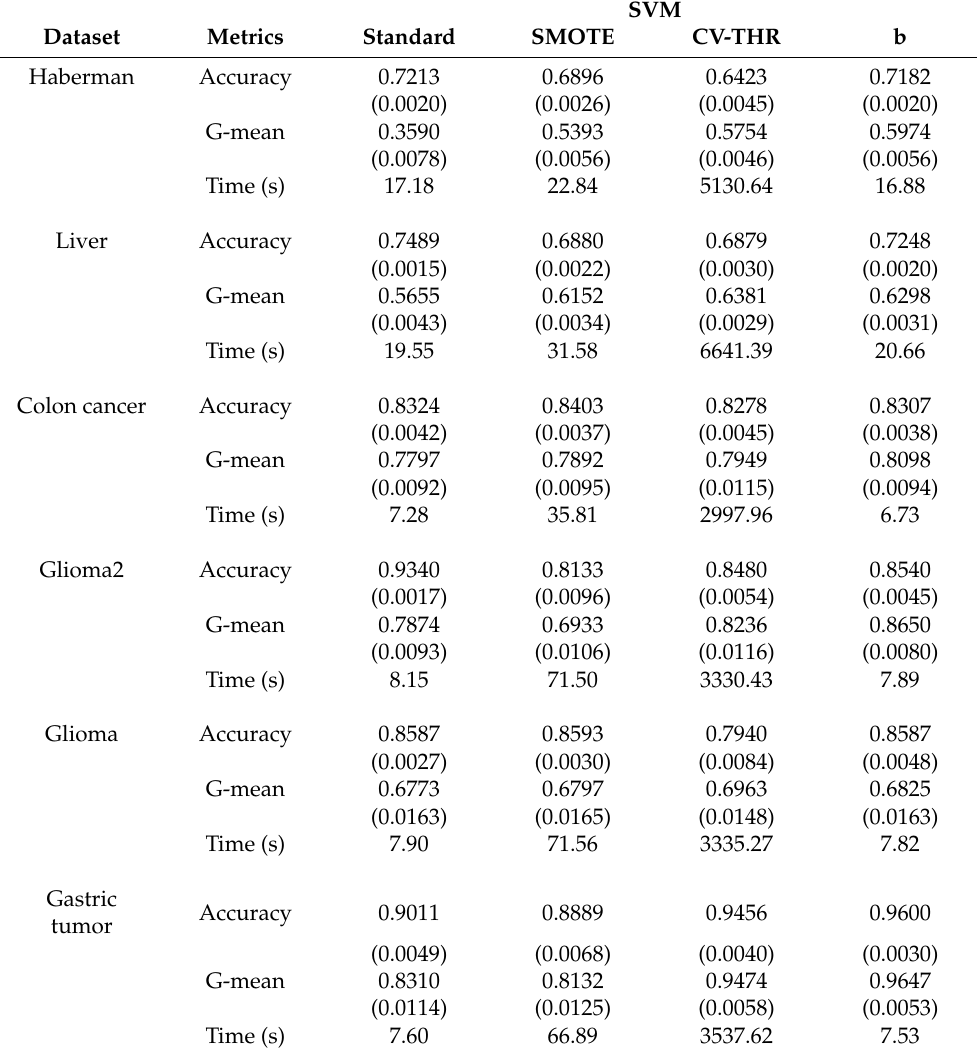
Table 5. Mean (standard deviation in parentheses) classification performance of SVMs in real datasets.